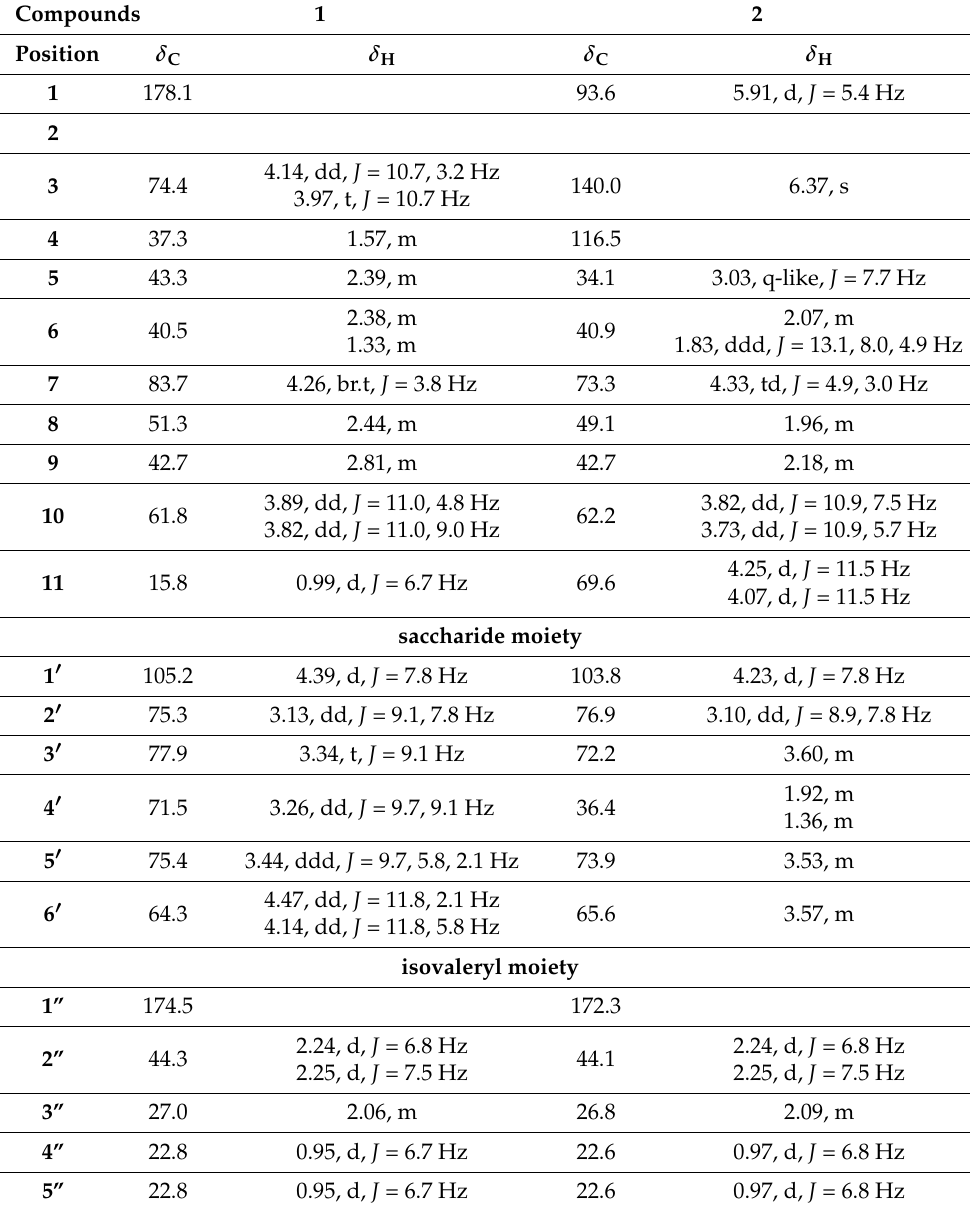
Table 1. 1 H-NMR (500 MHz) and 13 C-NMR (125 MHz) spectroscopic data of compounds 1 and 2 (in CD 3 OD, δ in ppm, J in